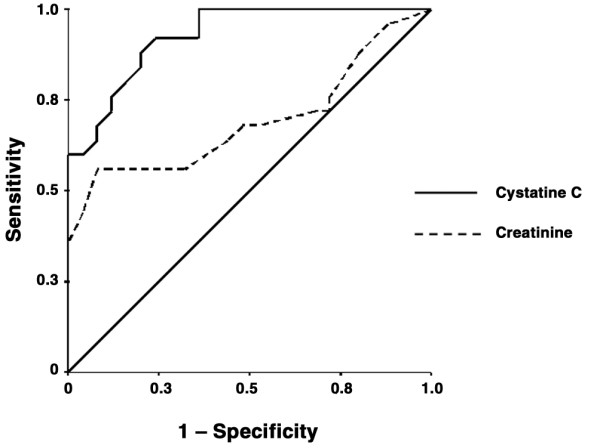
Nonparametric receiver operating characteristic plots of sensitivity and specificity of serum creatinine and cystatin C. Area under the curve (95% confidence interval): creatinine 0.694 (54.1–84.6) and cystatin C 0.927 (86.1–99.4).